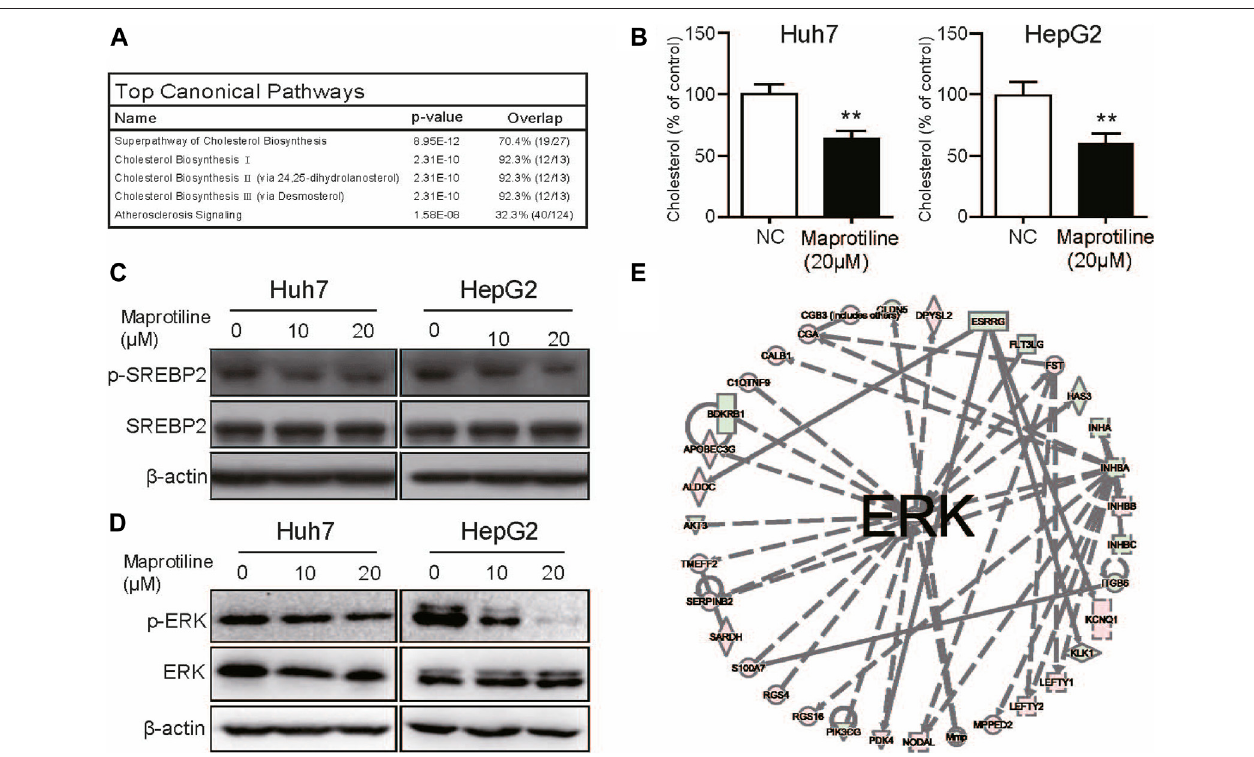
FIGURE 4 | Maprotiline arrests cholesterol biosynthesis in HCC cells through the ERK pathway. (A) Top 5 RNA-seq pathways in enrichment analysis. (B) Cholesterol levels in the maprotiline-treated HepG2 and Huh7 cells. (C) Ingenuity pathway analysis (IPA) re fl ected dysregulation of the ERK pathway in the maprotiline- treatedHepG2cells. (D) WesternblotofphosphorylatedSREBP2 inthemaprotiline-treated HepG2and Huh7cells. (E) HepG2and Huh7cellswerecultured with0,10, or 20 μ M maprotiline for 72 h, and ERK and p-ERK were detected by Western